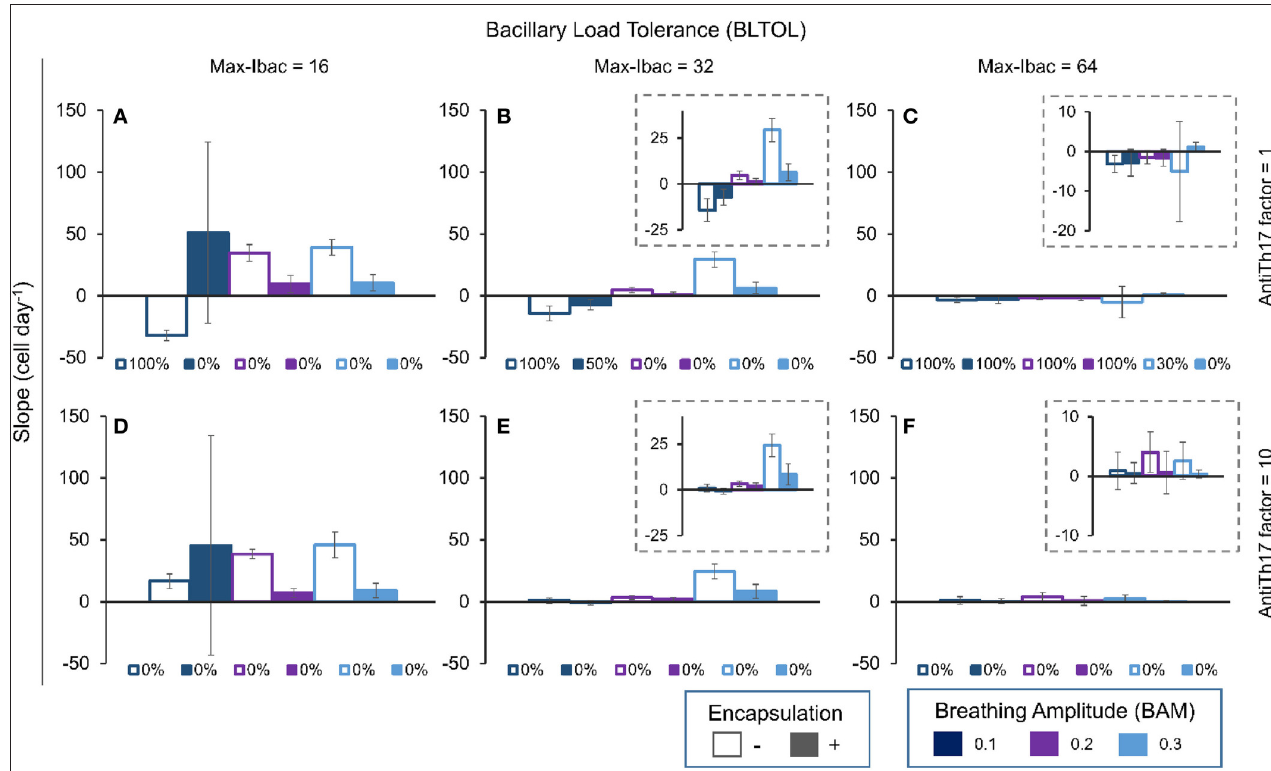
FIGURE 12 | Influence of different parameters on the slope of aAM evolution at day 42. Maximum bacillary load per macrophage (BLTOL): 16 (A,D) , 32 (B,E) , 64 (C,F) . AntiTh17 factor: 1 (A–C) , 10 (D–F) Encapsulation factor: − , no encapsulation, + , encapsulation. Breathing amplitude (BAM): 0.1, 0.2, 0.3. Bars indicate the mean of 10 runs. Individual legends indicate the percentage of 10 runs in which the PMN population exceeded the aAM